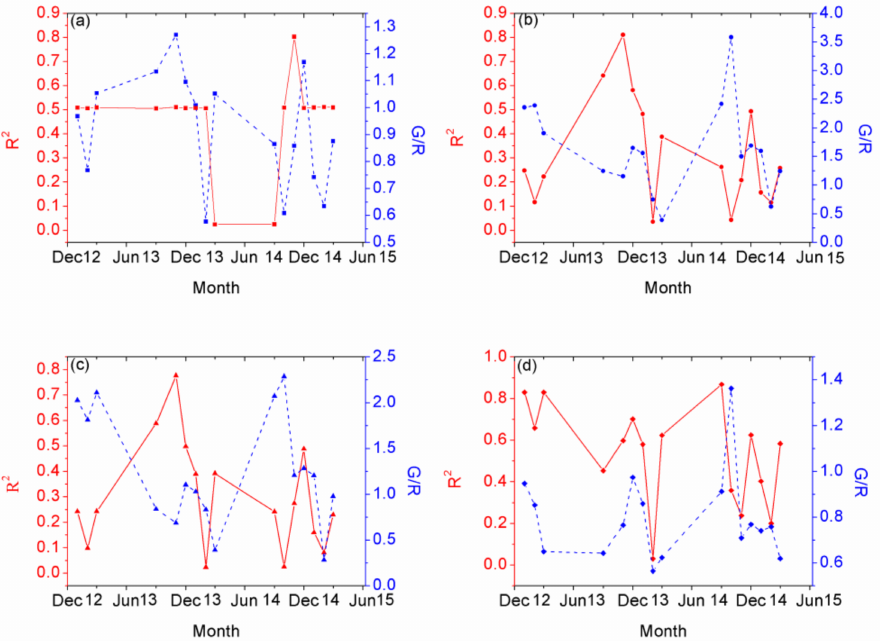
Figure 8. Plot of R 2 and G/R of radar rainfall estimates on a monthly basis for all rainfall intensity for ( a ) LM, ( b ) MP, ( c ) ROS, and ( d ) ANN